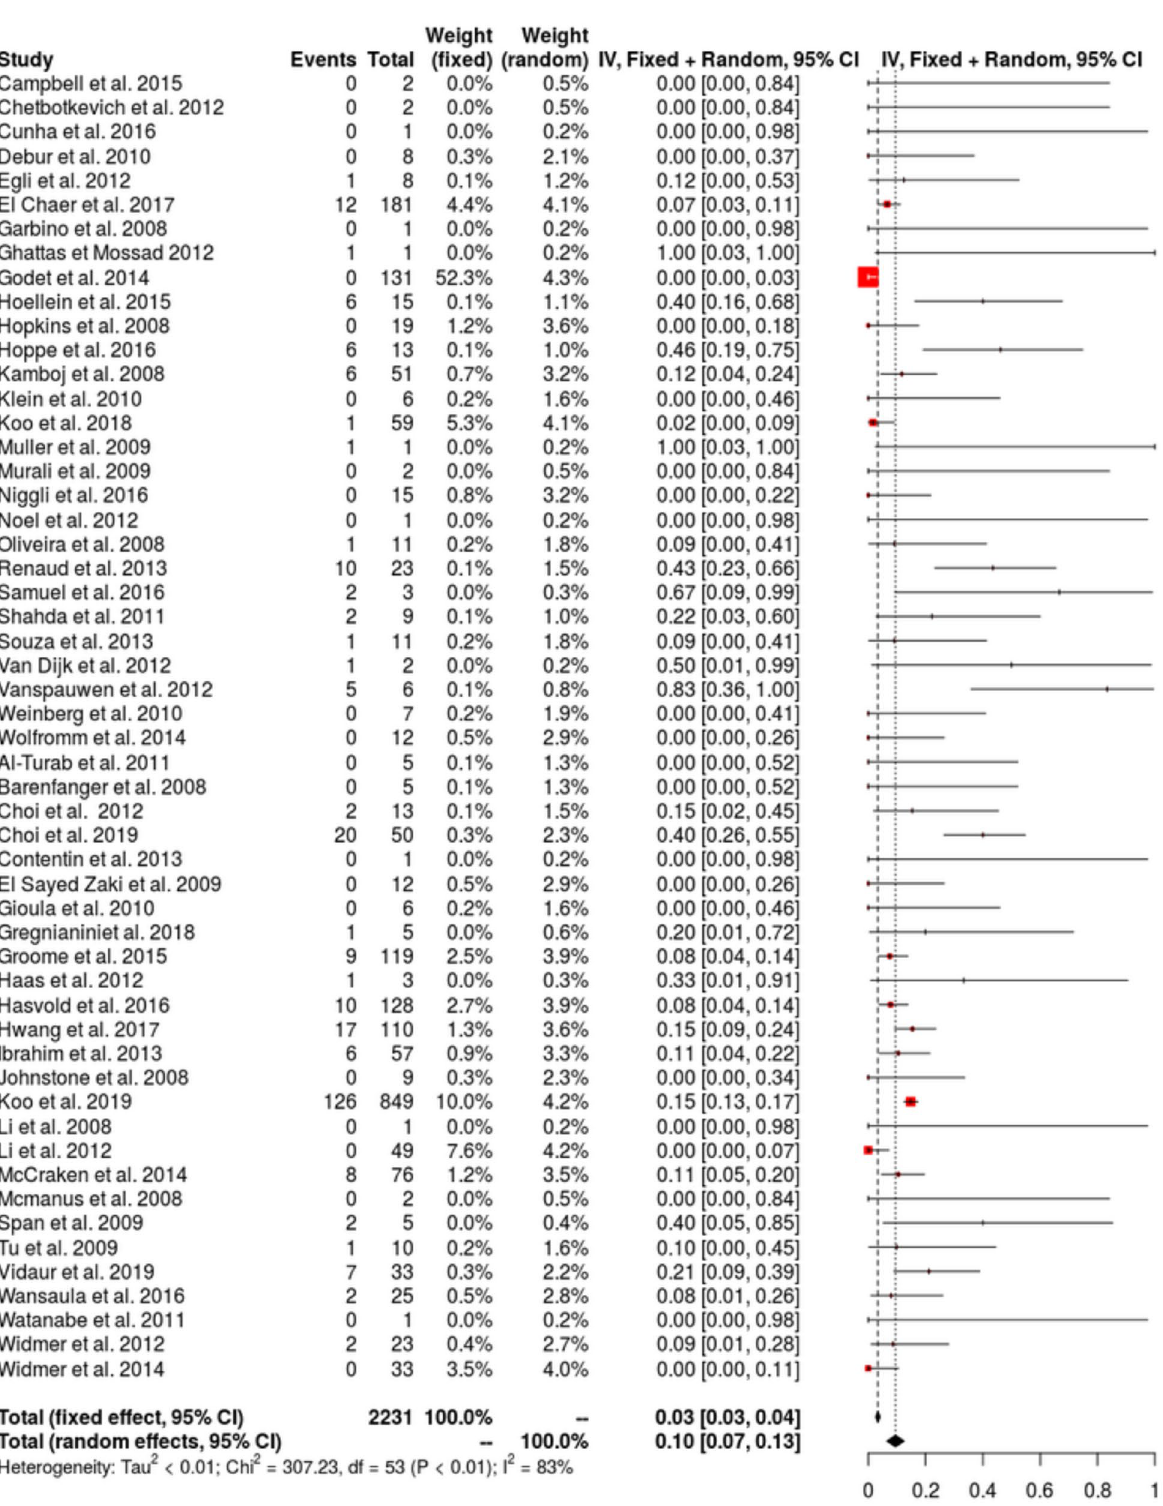
Fig. 5 Forest-plot presenting the estimated mortality rate in adults with hMPV infection (URTI and